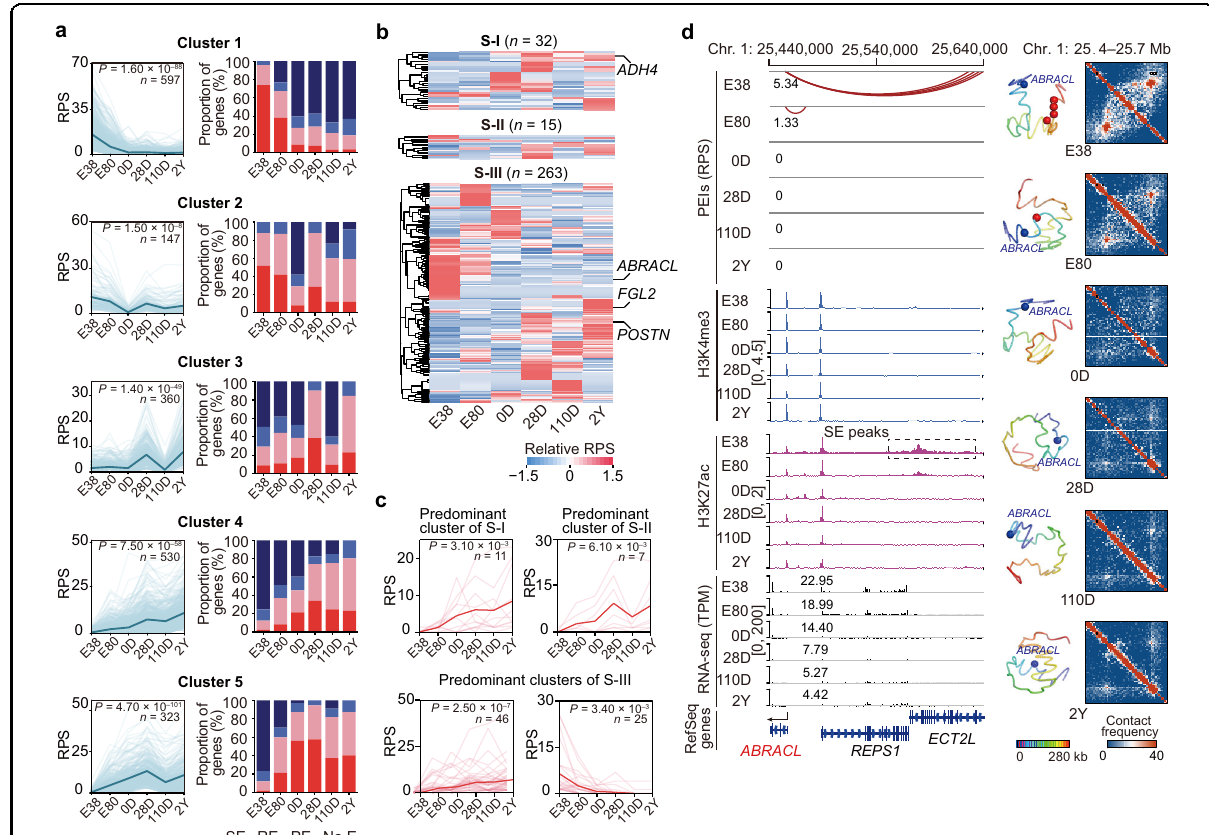
Fig. 4 Developmental-dependent changes of PEI-associated transcriptional regulation. a Developmental-dependent changes in gene RPS (|log 2 FC | > 2 and | Δ RPS | > 3) between consecutive stages were classi fi ed into fi ve clusters using the STEM algorithm (left). The bold lines indicate the mean RPS, and the thin lines represent the RPS of each gene in the relevant cluster during development. FDR-corrected P -values were obtained from multiple hypothesis testing. The proportion of genes that interacted with differently active enhancers (activity ranking: super-enhancer (SE) > regular- enhancer (RE) > poised-enhancer (PE)) at each stage were consistent with the dynamic RPS (right). b Heatmaps showing temporal RPS patterns of the signature genes in three HCC subtypes (S-I, S-II, or S-III) across stages. Genes were grouped using hierarchical clustering. Four signature genes are labelled on the plot. c Predominant RPS patterns of signature genes for three HCC subtypes identi fi ed using the STEM algorithm. d PEI rewiring of ABRACL , a signature gene in S-III HCC. Left: Schematics of PEIs, H3K4me3, and H3K27ac signals, and transcription. Dashed boxes highlight super- enhancer (SE) peaks. Right: 3D structural models and Hi-C contact maps of the corresponding genomic region (seven 5 kb bins up- and downstream from the bin containing the transcription start site (TSS)). Gene promoters and enhancers are shown as blue and red spheres in the 3D models,